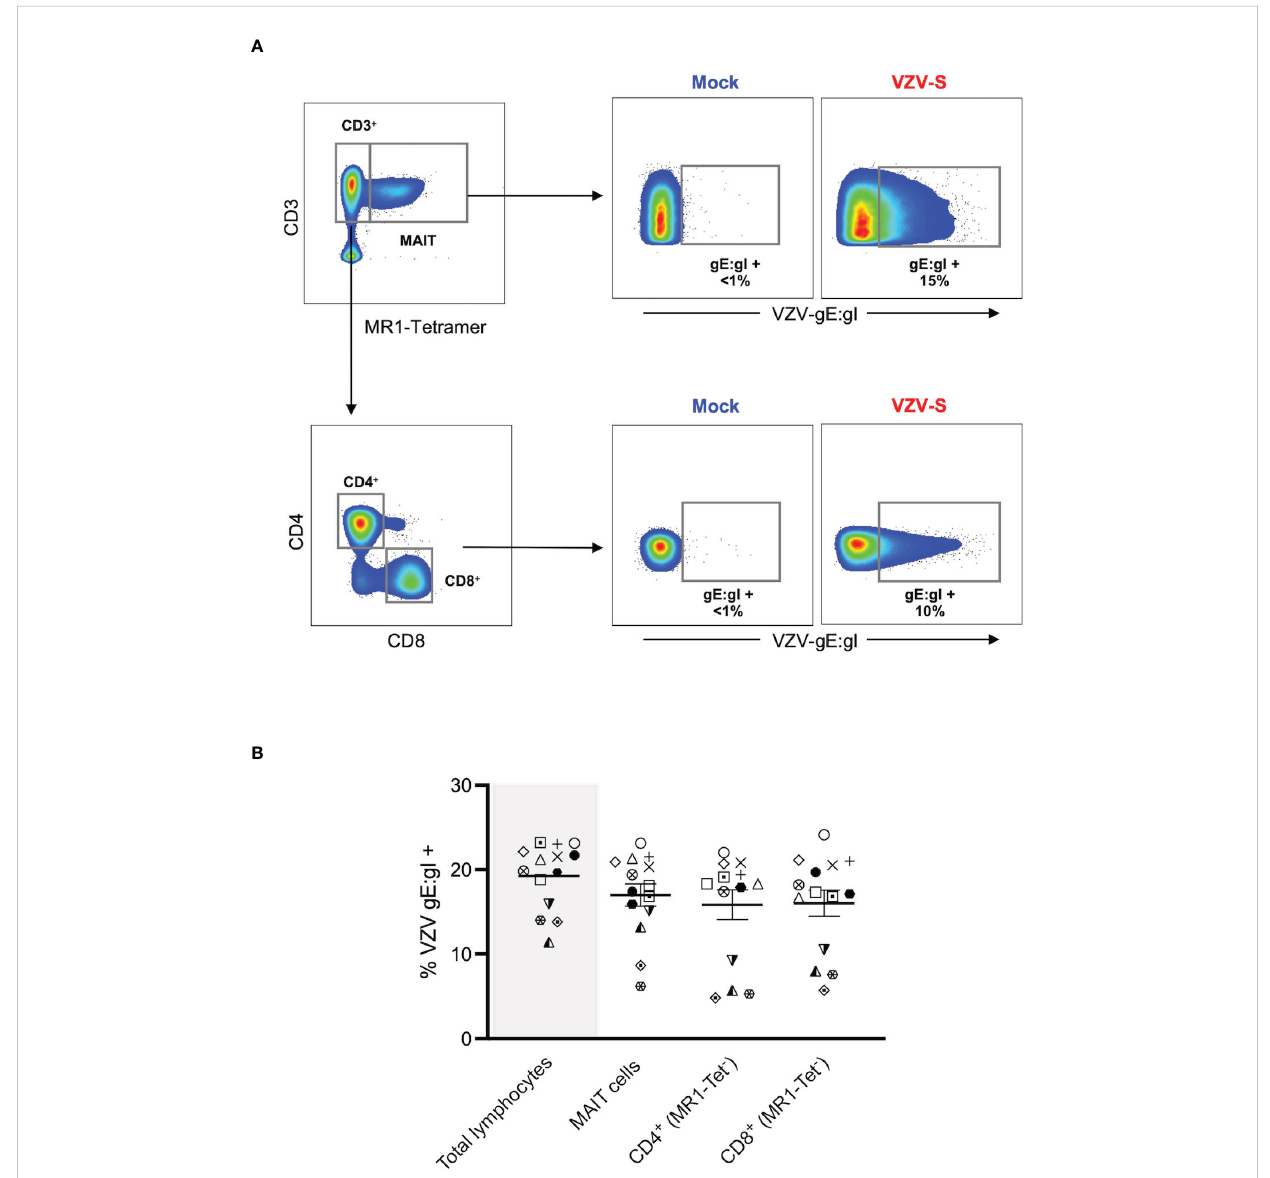
FIGURE 1 VZV infects MAIT cells from human peripheral blood. Human PBMCs were inoculated with mock or clinical VZV isolate (VZV-S) infected ARPE-19 epithelial cells for 2 days and then analyzed for infection by fl ow cytometry. (A) Representative fl ow cytometry plots depicting gating strategy of CD3 + MR1-Tetramer + (MR1-Tet + ) MAIT cells, non-MAIT (ie MR1-Tet - ) CD3 + CD4 + (CD4 T cells) and non-MAIT (ie MR1-Tet - ) CD3 + CD8 + cells (CD8 T cells), as well as quantifying surface VZV glycoprotein (g)E:gI expression on gated populations. (B) Frequencies of total live gE:gI + lymphocytes (shaded), compared to MAIT cells, non-MAIT CD4 + and non-MAIT CD8 + cells (n=14). Symbols represent individual donors across the lymphocyte populations, with mean and standard error of mean (SEM) indicated by the bars. Statistical analysis between gE:gI expression on speci fi c lymphocyte populations was performed via repeated measures (RM) one-way ANOVA with the Greenhouse-Geisser correction and Tukey ’ s multiple comparisons